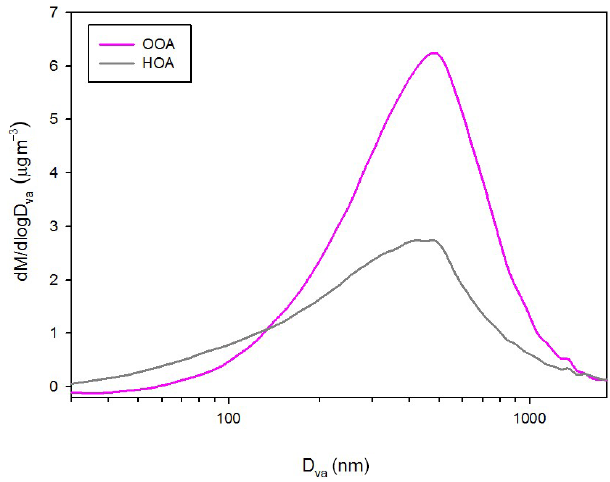
Figure 6. Campaign-averaged size-resolved volume fraction of chemical species with κ values ( κ HTDMA ) for 50, 100, and 150nm (mobility diameter, D m , for κ values is converted to aerodynamic diameter, D va , for